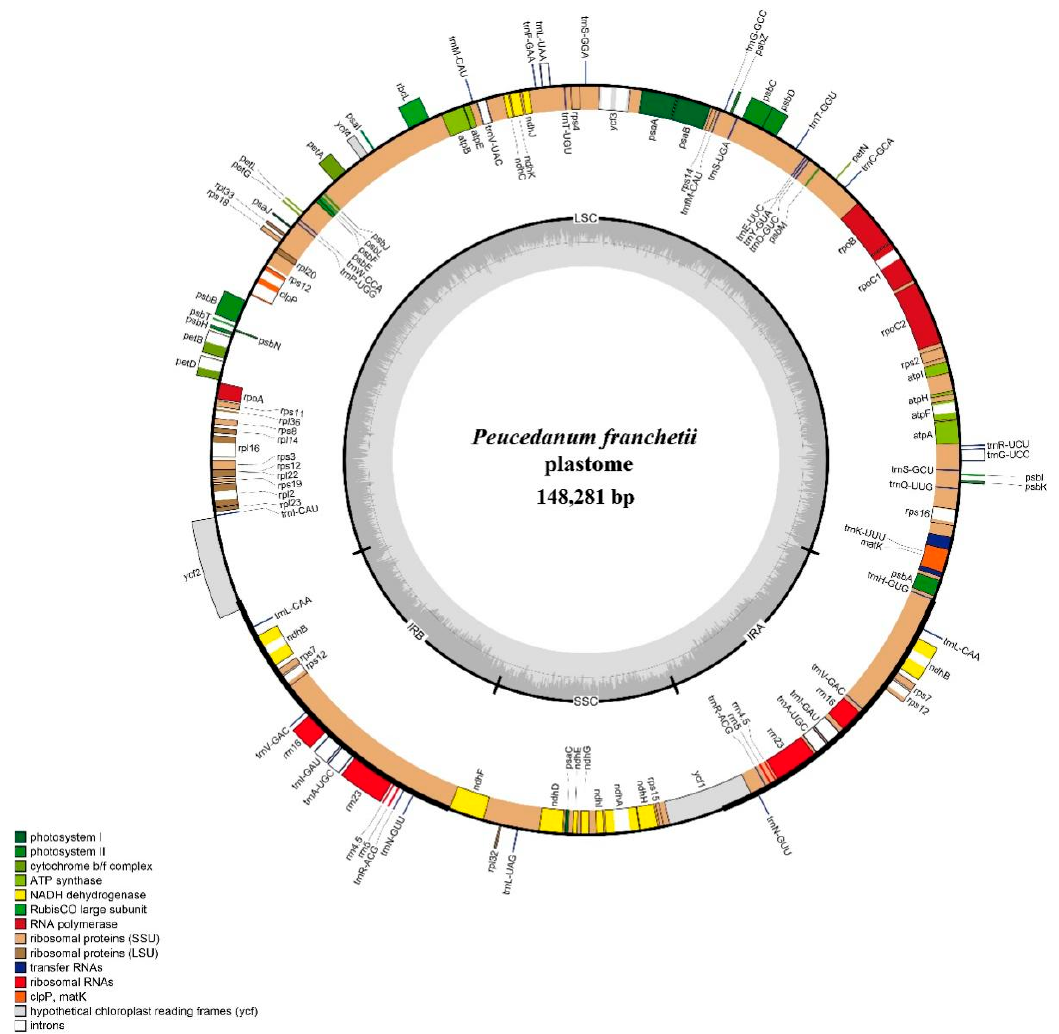
Figure 2. Gene map of the P. franchetii plastome. The genes exhibited outside of the circle are transcribed clockwise, while those are counterclockwise inside. The genes belonging to different functional groups are color-coded.